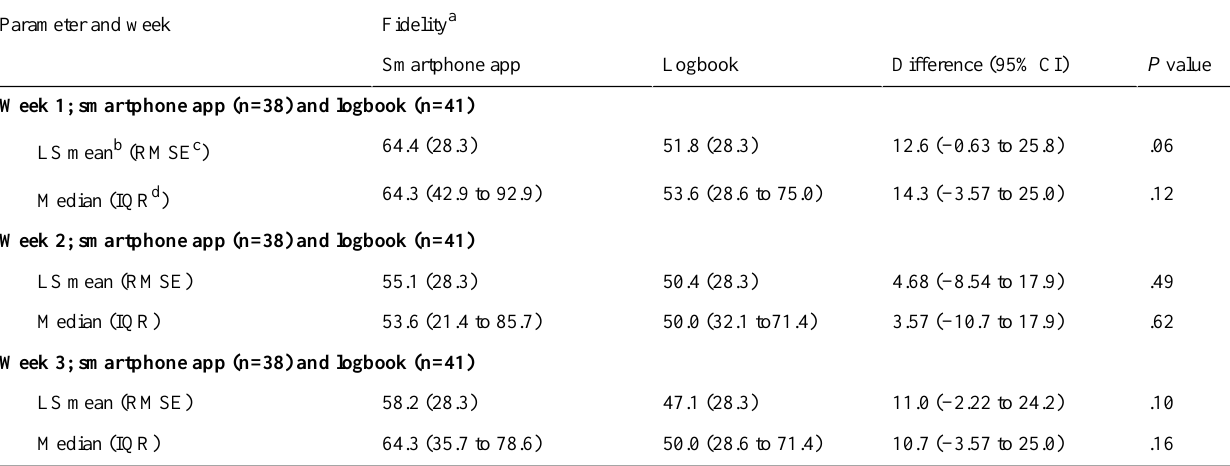
Fidelity a Parameter and